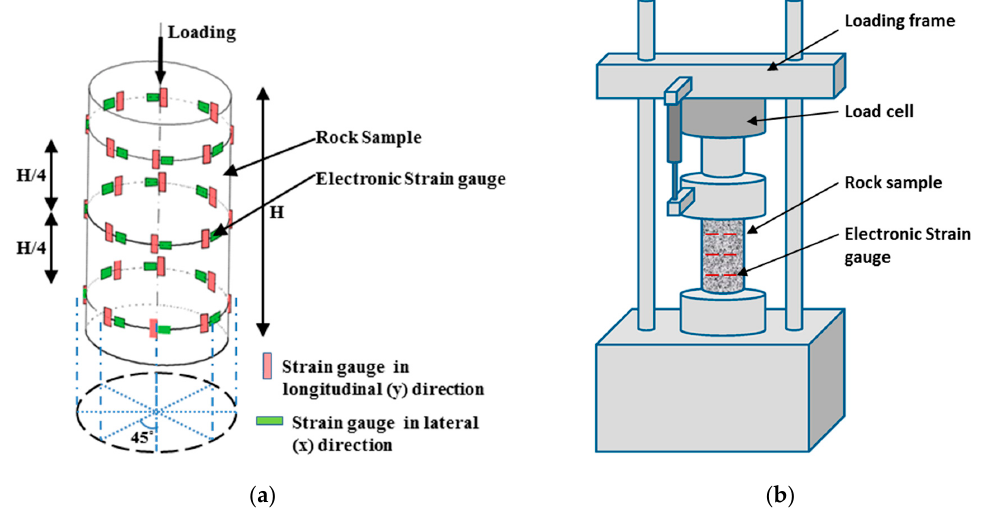
Figure 1. ( a ) Details of strain gauge location with uniaxial load of rock sample and ( b ) Experimental Setup.